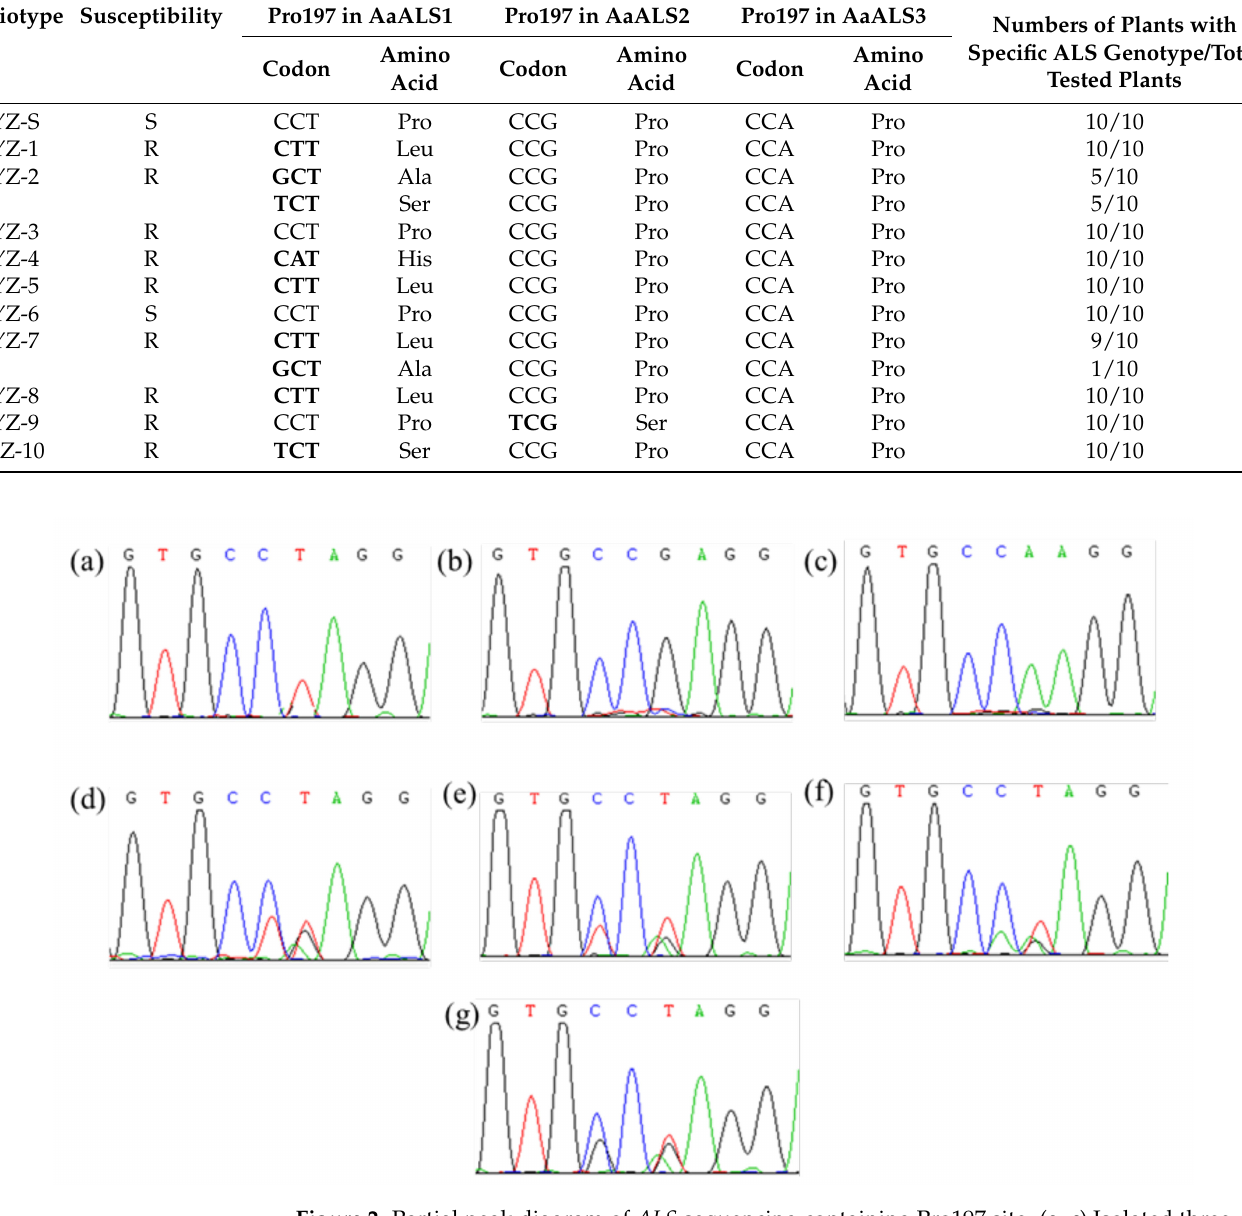
Figure 2. Partial peak diagram of ALS sequencing containing Pro197 site. ( a – c ) Isolated three ALS genes; ( d – g ) four different amino acid mutations at